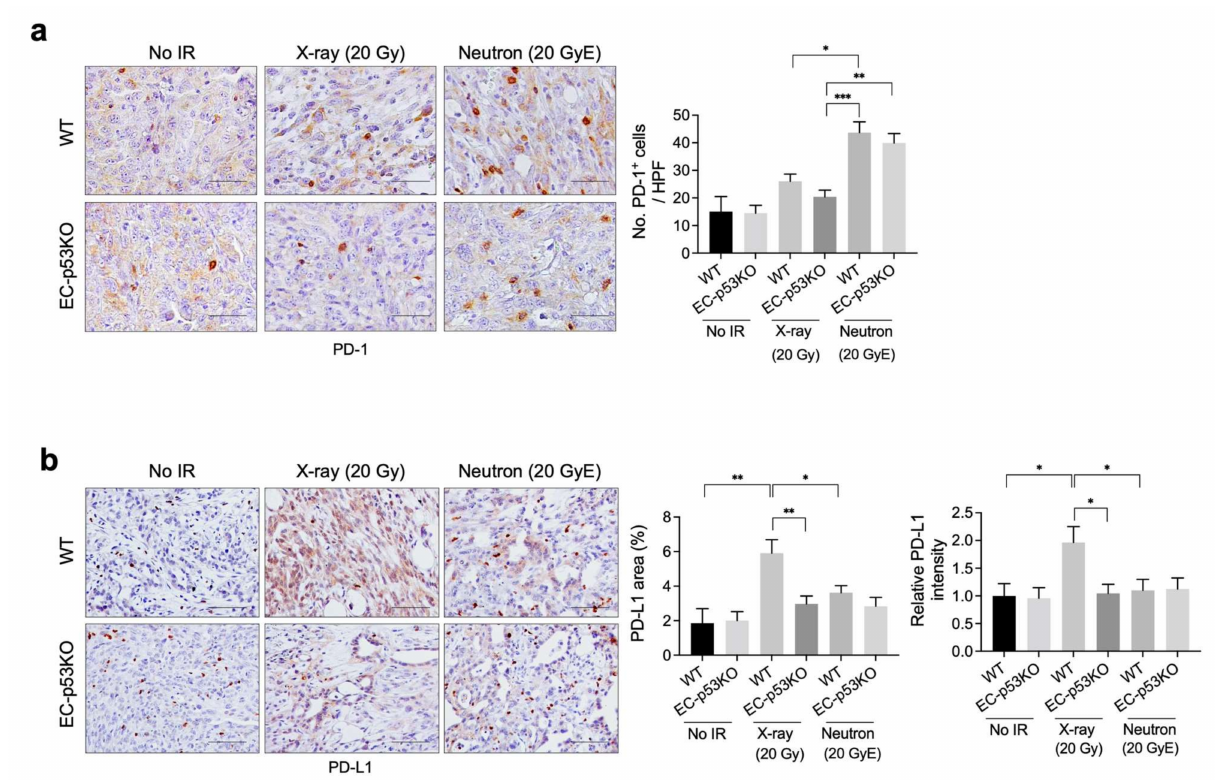
Figure 4. Neutron irradiation induces lower PDL-1 expression than X-ray irradiation in the KP tumors of WT mice and EC-p53KO mice. Non-irradiated tumor tissues obtained on day 0 and tumor tissues obtained on day 15 after irradiation were used for staining. ( a , b ) Immunohistochemistry of PD-1 (brown color) and PD-L1 (brown color) in irradiated and non-irradiated KP tumors from WT and EC-p53KO mice. ( a ) Scale bar = 20 µ m; ( b ) Scale bar = 40 µ m. Quantification of an average of five fields with a prominent PD-1+ cell population and a high PD-L1-positive area per field (magnification, 200 × , n > 5). For all graphs, error bars indicate the SEM (one-way ANOVA for multiple comparisons). * p < 0.05, ** p < 0.01, *** p <